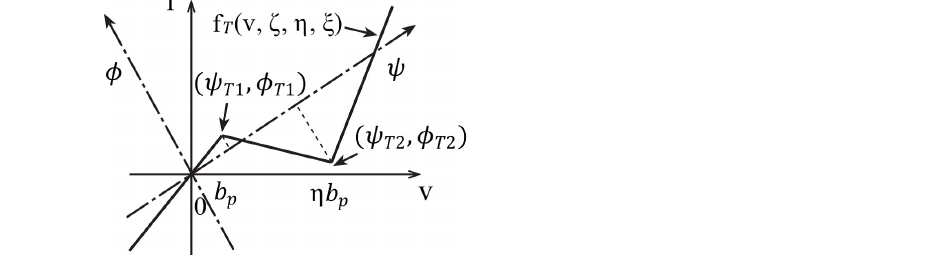
Figure A2. The characteristics of TD 3SPWL Resistor in ( ψ , φ ) and ( v , i ) coordinate